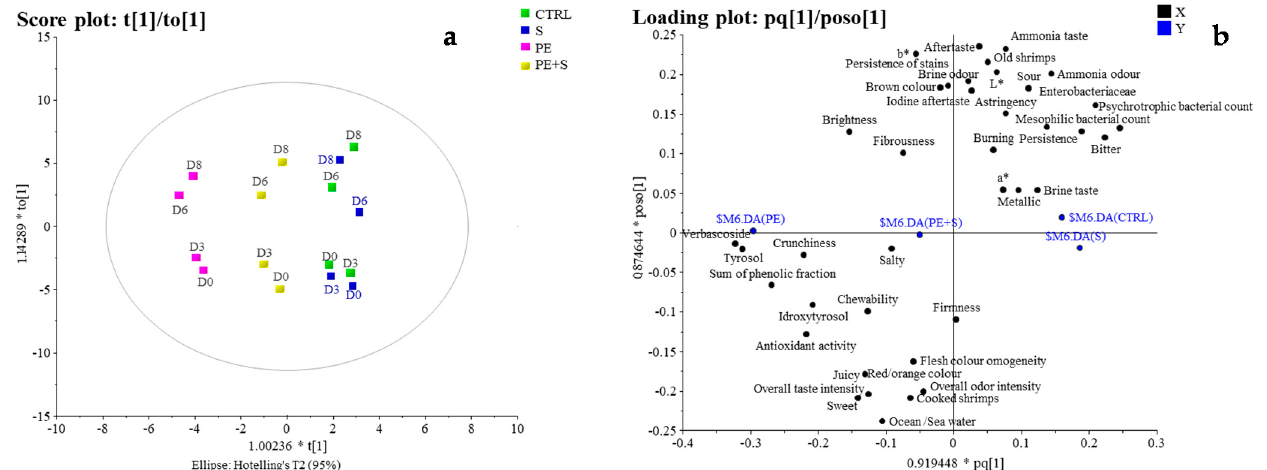
Figure 4. Score ( a ) and loading plot ( b ) of the OPLS-DA model built with all the samples and the variables. The model with one predictive component and one orthogonal component explains 58% of the variance of the data (19% and 39%, respectively).